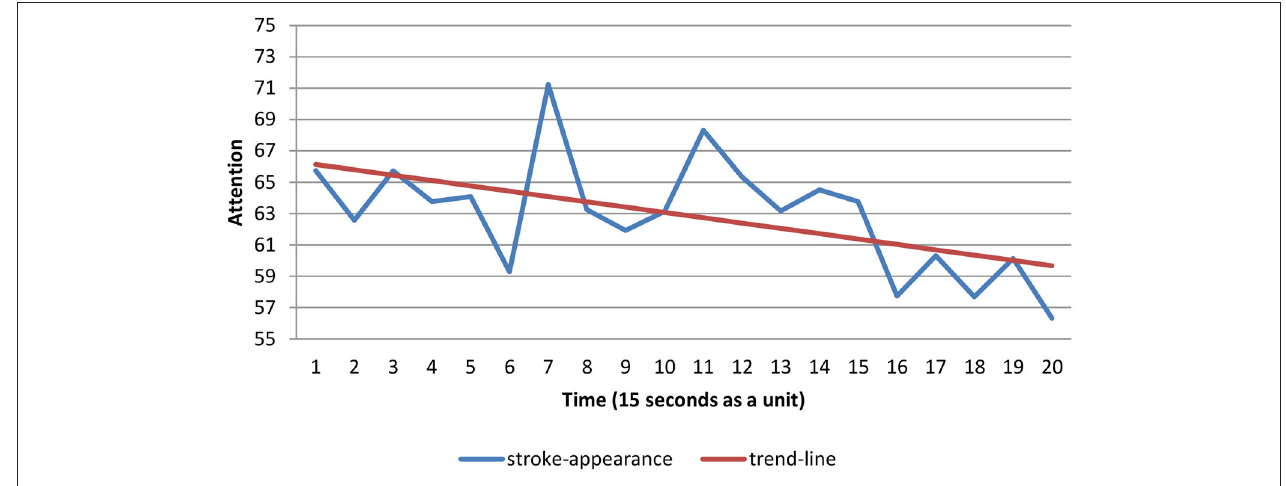
FIGURE 1 | Time series chart of